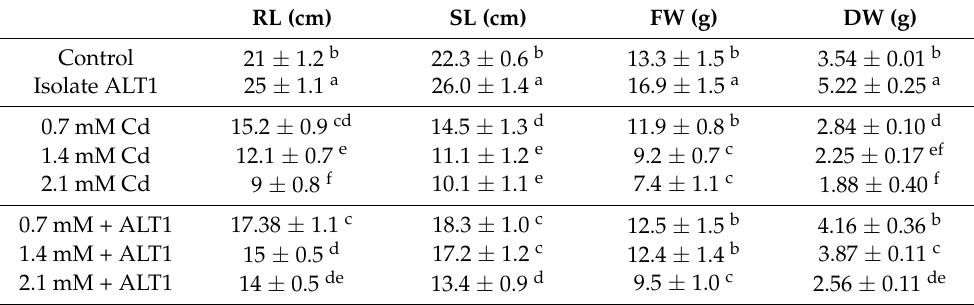
Figure 1. Effects of Cd stress on growth of ALT1-inoculated and non-inoculated soybean plants. Table 1. Growth promoting effect of Bacillus cereus ALT1 on soybean under various cadmium stress. The values with ± show standard deviation (SD). RL: root length; SL: shoot length; FW: fresh weight; DW: dry weight. The superscript letters after the mean values in a column indicate significant differences. Each value represents the mean ± SD (n =